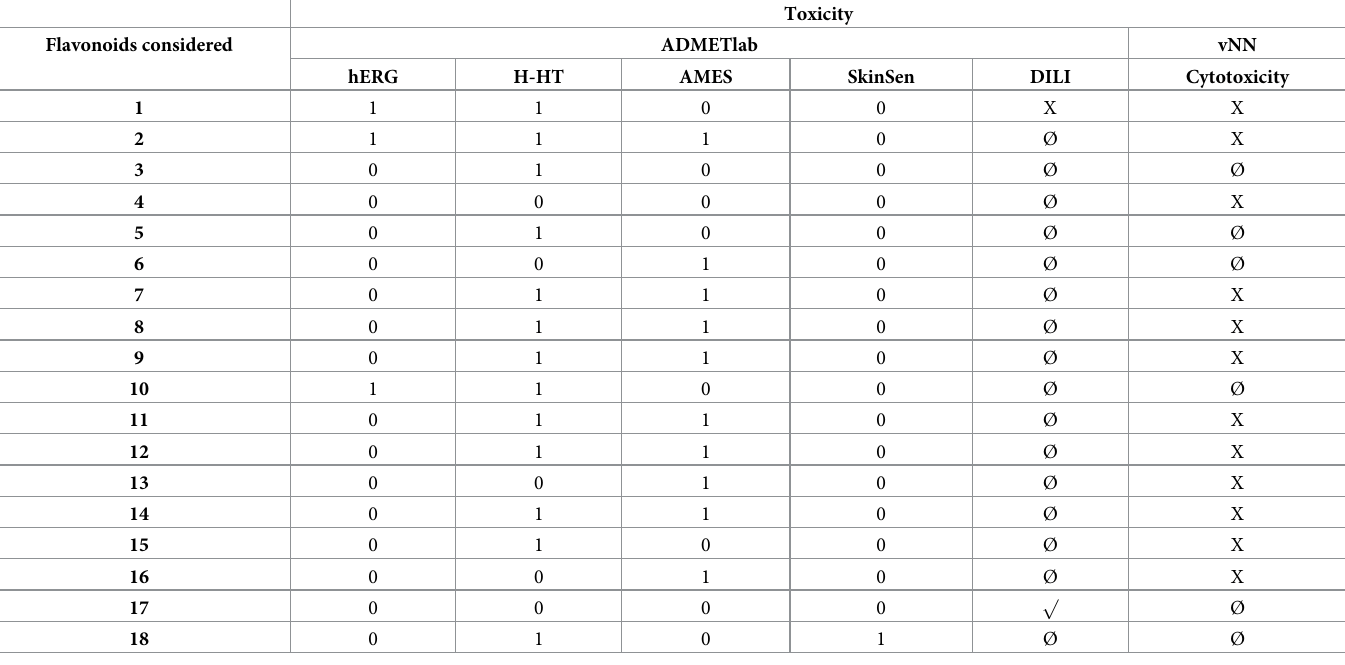
p The symbols X, and Ø represents inactive, active and no high confidence prediction available,